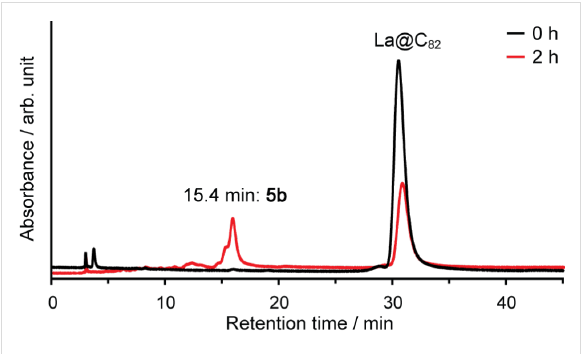
Figure 10: HPLC profiles of the reaction mixture for 5b . Conditions: column, Buckyprep (Ø 4.6 mm × 250 mm); eluent, toluene; flow rate, 1.0 mL/min; wavelength: 330 nm; 40 °C.